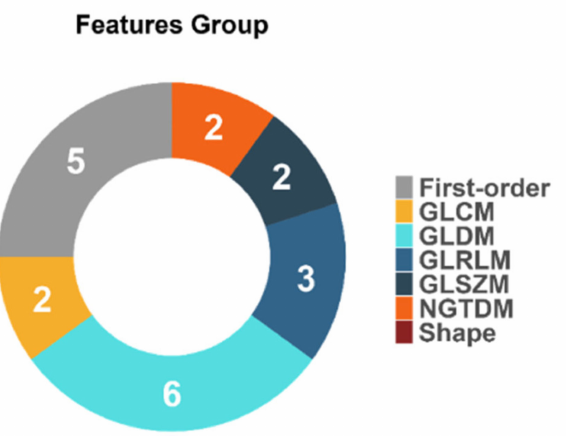
Figure 8. Feature distributions according to the group of the calculated radiomics features. Global model interpretability of the optimal p_MRI-based radiomics analysis pipeline with regard to the prediction performance was obtained using LIME (Figure 9). Summary plot of the corresponding SHAP values is shown in Figure 10.